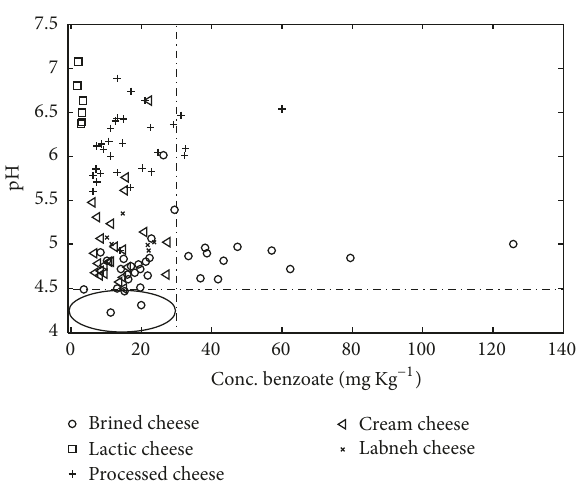
Figure 6: Illustration of the concentration of Sorbate and pH for each cheese sample. The samples that are located outside the violet rectangle have more than allowed concentration of sorbate and pH.